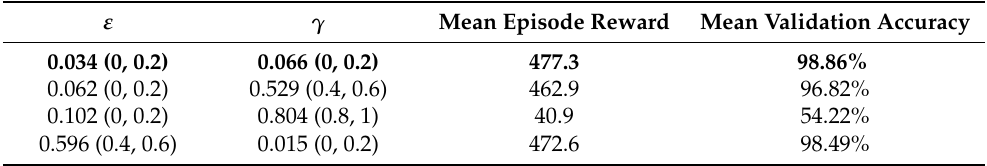
Table 15. Performances (averaged over the last 10 episodes) on validation set. (a, b) denotes the search space for the Bayesian search algorithm.